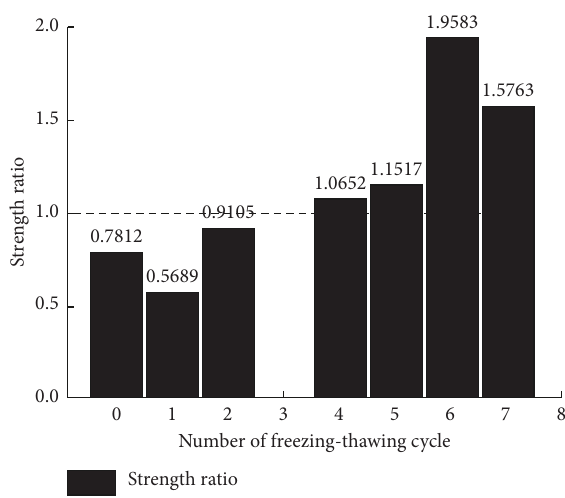
Figure 13: Fiber infuence strength ratio in a water environment.